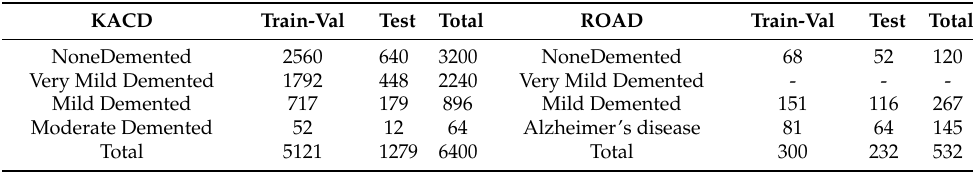
Table 1. Distribution of the Kaggle Alzheimer’s classification dataset (KACD) and Recognition of Alzheimer’s Disease dataset